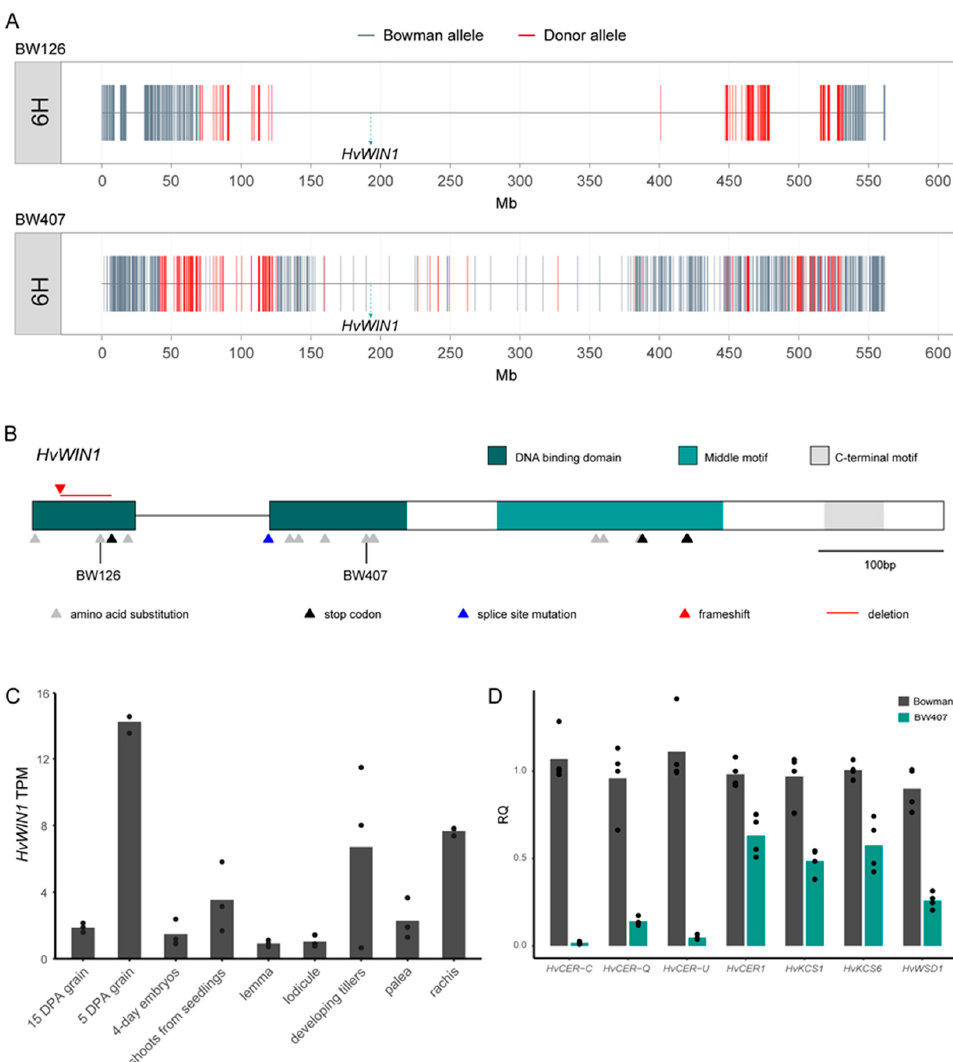
Figure 2. HvWIN1 underlies the Cer-X locus in barley. ( A ) Barley 50k iSelect SNP chip [50] plotted over chromosome 6H of BW126 and BW407. ( B ) HvWIN1 gene model ( HORVU6Hr1G038120 ). Var- iants in independent cer-x alleles are represented as triangles. Triangles are coloured based on mu- tation type. ( C ) Expression of HvWIN1 in Morex tissues from the Barley Expression Database (EoRNA [54]). Data expressed in transcripts per million (TPM). Bars represent mean expression. N = 3. ( D ) Expression of HvWIN1 putative downstream targets in Bowman and BW407 hull tissues at five days post anthesis (DPA). Expressed as relative quantity (RQ). N = 3.